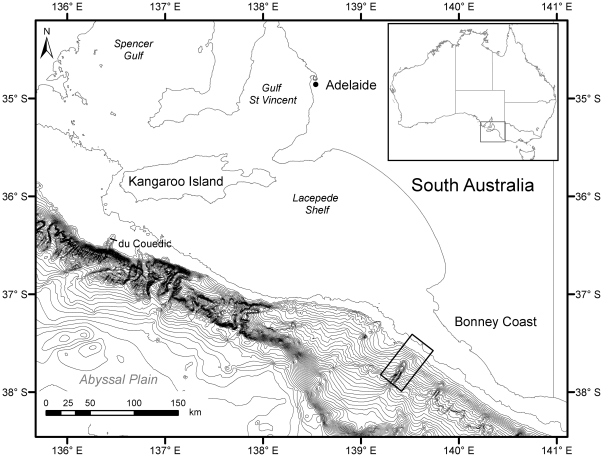
Map showing the location of the study area (unfilled rectangle) on the south-east Australian continental slope.Contour lines presented follow 100 m depth intervals.